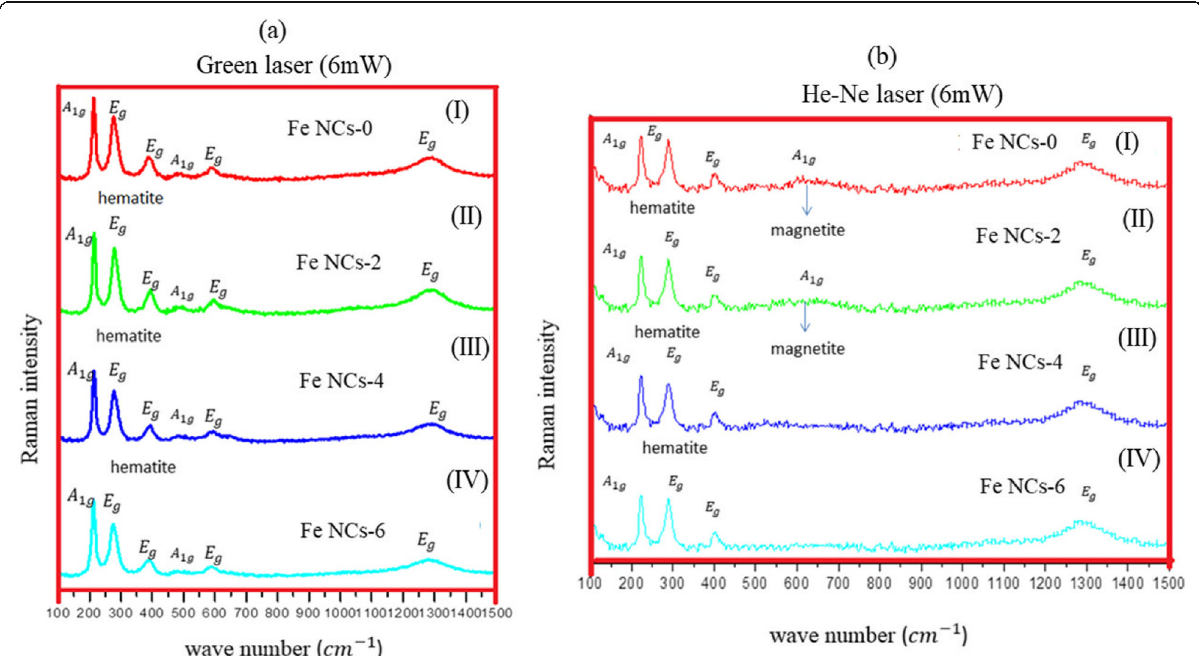
Fig. 7 Raman Spectra of a Fe NCs-0 (I), Fe NCs-2 (II), Fe NCs-4 (III), and Fe NCs-6 (IV) collected at 6 mW laser power with Green laser and b Fe NCs-0 (I), Fe NCs-2 (II), Fe NCs-4 (III), and Fe NCs-6 (IV) collected at 6 mW laser power with He-Ne laser